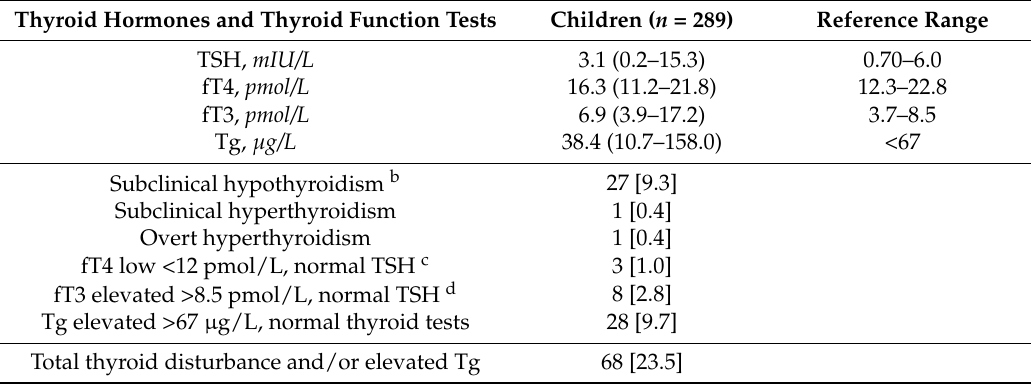
Table 4. Thyroid hormone status and thyroid function tests among children at follow-up a